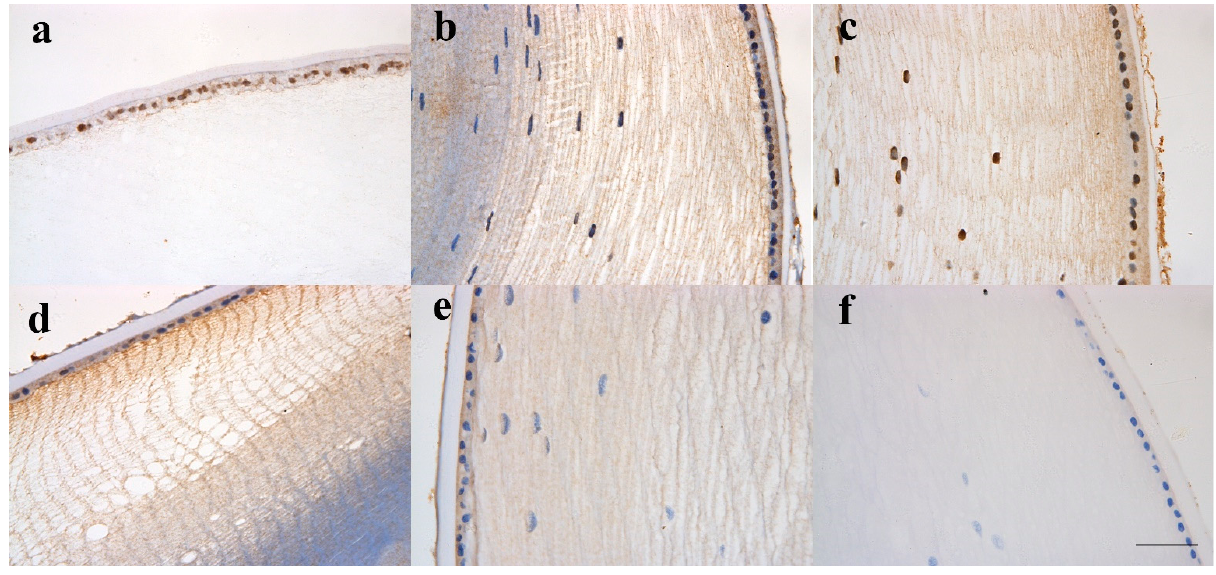
Figure 4. Images of immunohistochemistry of the stained HTRA1 for transparent lens from donors of different ages. ( a ). Image of a 19-day-old boy; ( b ) image of a 2-month-old boy; ( c ) image of a 3-month-old girl; ( d ) image of a 15-month-old boy; ( e ) image of a 19-year-old girl; ( f ) negative control image of a 2-month-old boy. The results indicated that the HTRA1 protein was located in the epithelial cells and outer fibre cells. The images are taken at a 20× magnification. Scale bar: 50 μ m.